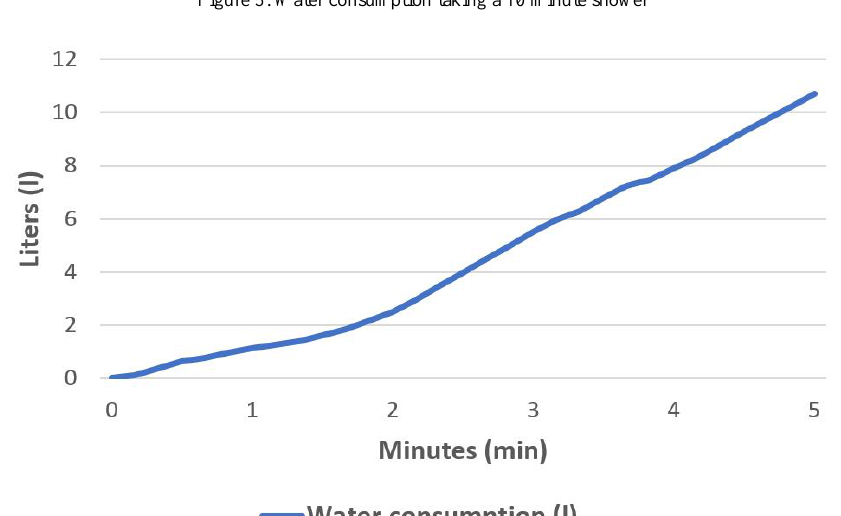
Figure 5. Water consumption taking a 10 minute shower